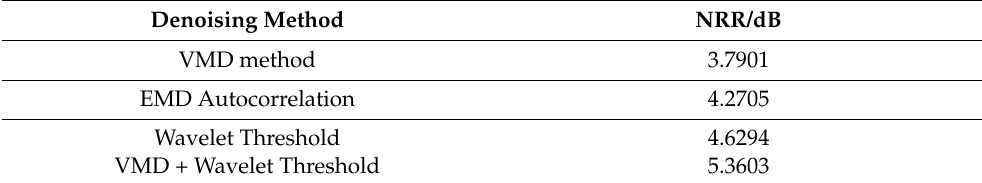
Table 2. Comparison of NRR calculation